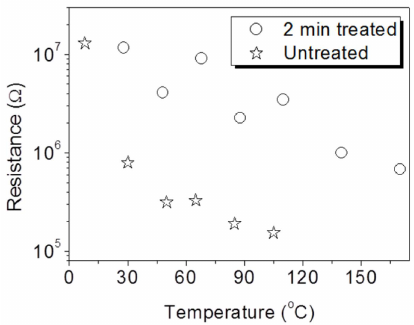
Figure 2. Temperature-dependent resistance of the low resistance state (LRS) memories with and without plasma treatment.